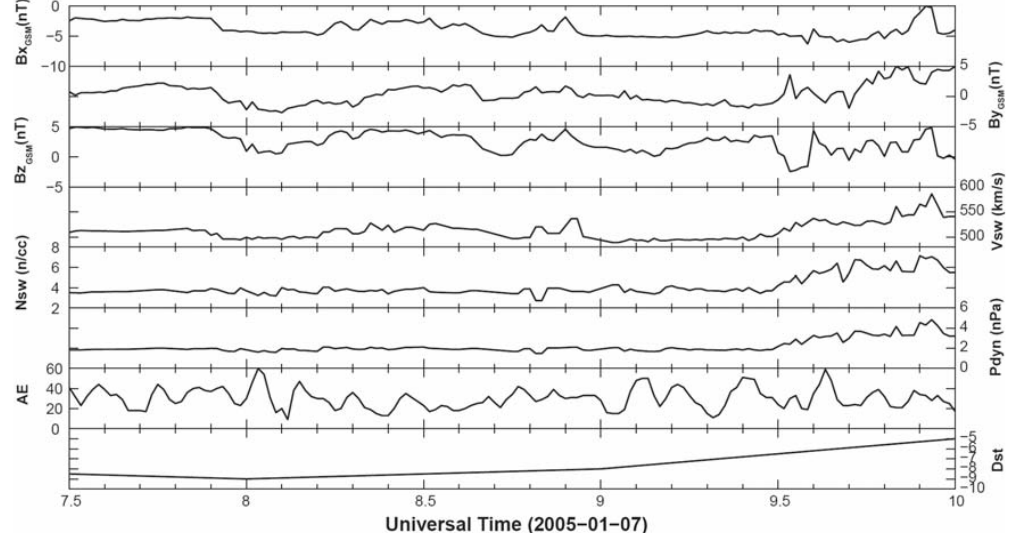
Fig. 3. Time series of solar wind parameters (including IMF B x , B y , B z , solar wind speed, proton density, and dynamic pressure) and geomagnetic indices (AE and Dst) corresponding to Fig. 2a. The plotted time has been adjusted by considering the solar wind speed and the propagation time from the spacecraft to the magnetosphere.